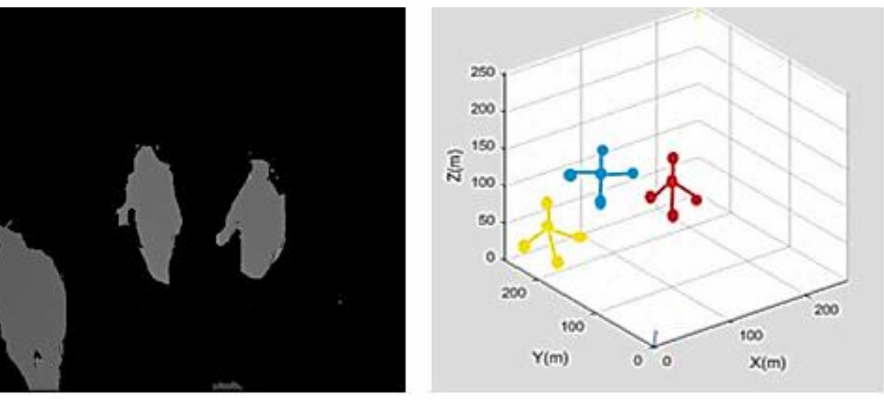
Figure 7. Fused intra-inter silhouette trajectories over the MICC